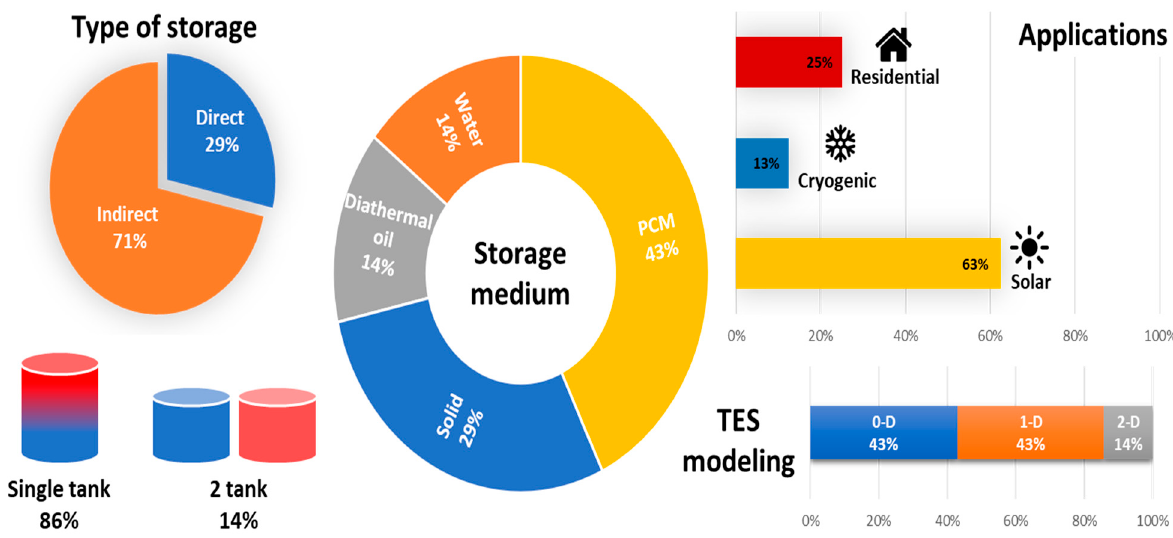
Figure 1. Type of storage, storage medium, TES modeling and application of the studied storage systems.